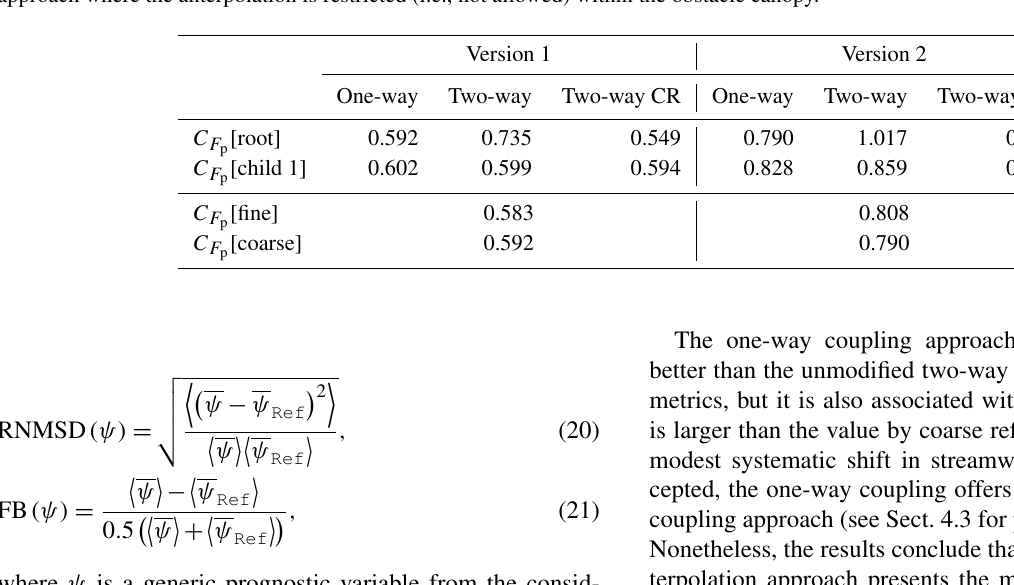
Table 2. Resultant pressure force coefficients C F evaluated over the child 1 ((cid:63)(cid:63)) domain shown in Fig. 16 (v1). Results for parent and child p solutions are reported for one-way, two-way, and two-way canopy-restricted (CR) methods, where the latter is a modified two-way coupling approach where the anterpolation is restricted (i.e., not allowed) within the obstacle